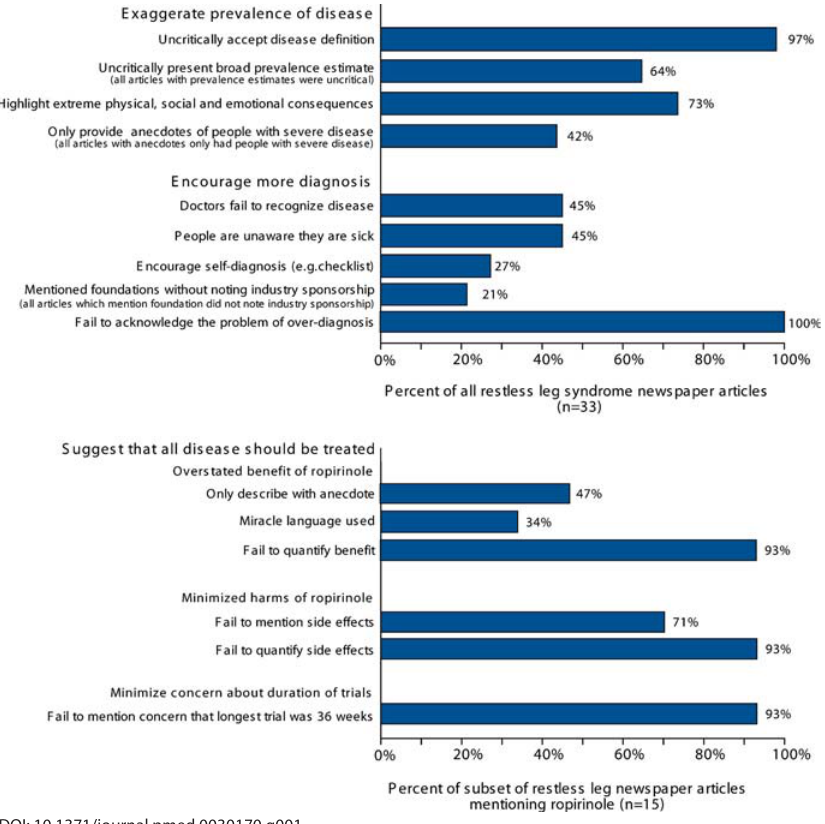
DOI: 10.1371/journal.pmed.0030170.g001 Figure 1. Frequency of Key Elements of Disease Mongering in Newspaper Articles Top bar graph analyzes all articles about restless legs syndrome. Bottom bar graph analyzes the subset that mentions